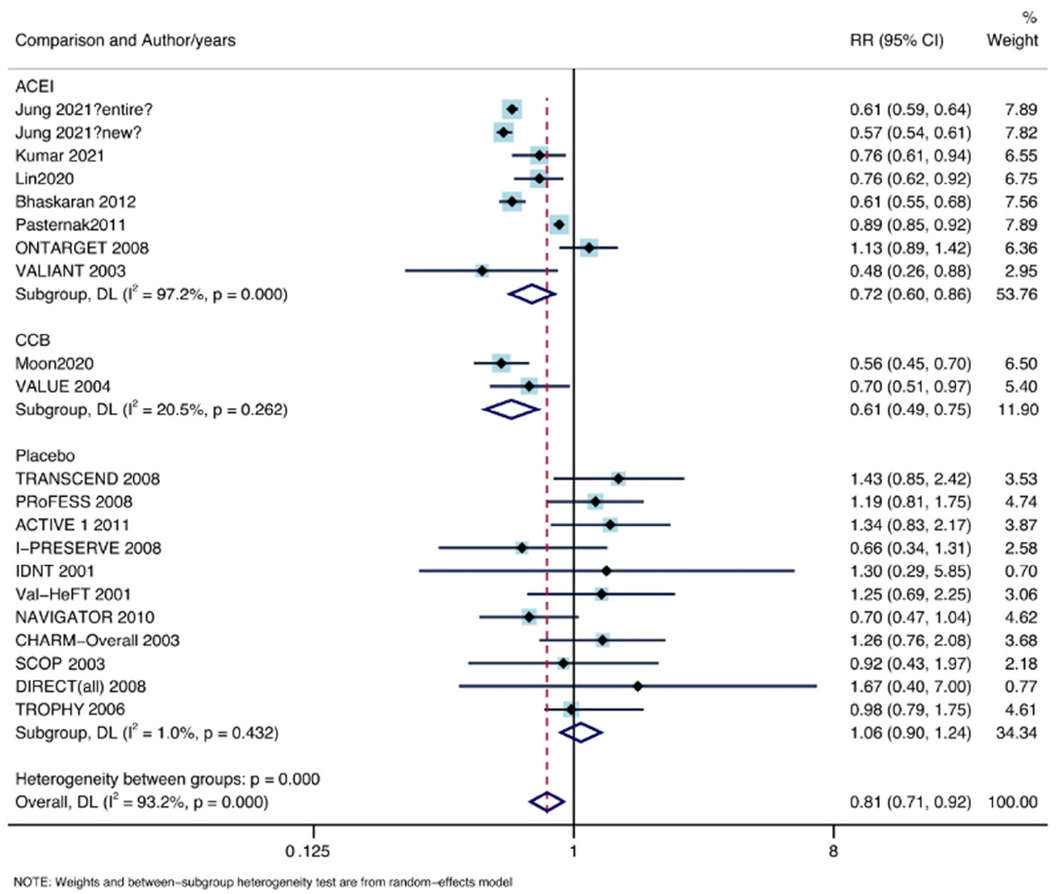
Figure 8. Subgroup analysis by comparison.